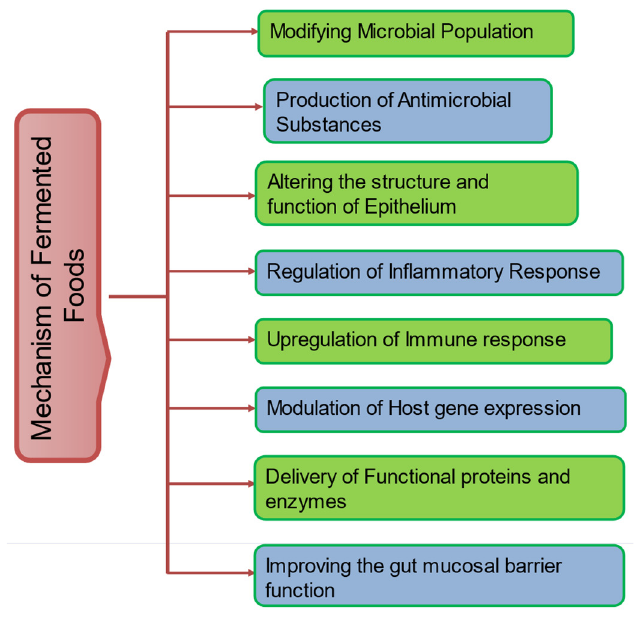
Figure 1. General mechanisms of fermented foods.